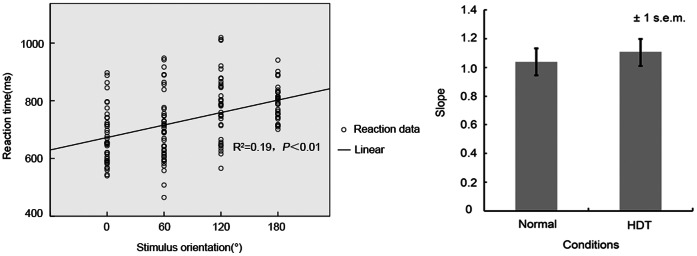
Behavioral results of mental transform test.Left: Lineal regression of reaction time and stimulus orientation in mental transform test (Subject 1 in normal condition as the example). Right: Velocity index of mental transformation in normal condition and simulated microgravity condition.